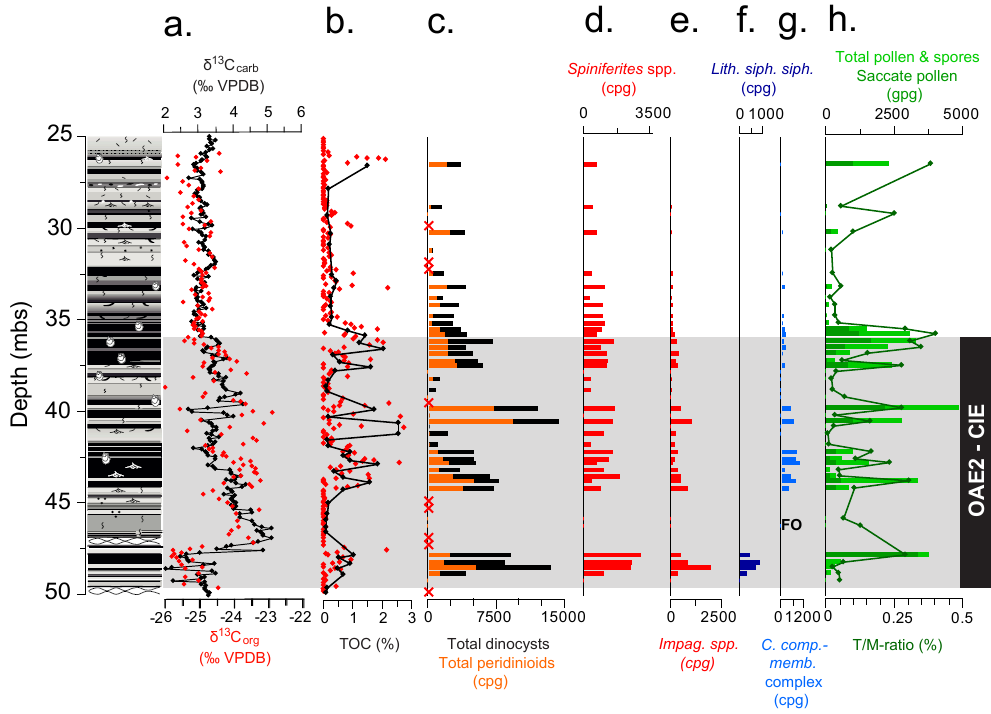
Figure 3. Geochemical and palynological results for the Cenomanian–Turonian transition of the Wunstorf core. Stratigraphy from Voigt et al. (2008). (a) δ 13 C carb (Voigt et al., 2008) and δ 13 C org (du Vivier et al., 2014; red). (b) Total organic carbon (TOC: black, this study; red, Hetzel et al., 2011). (c) Total dinocyst concentrations (black) and total peridinioid cysts (orange) per gram sediment dry weight (cpg). (d) Dinocyst species Spiniferites spp. (cpg). (e) Dinocyst species Impagidinium spp. (cpg). (f) Dinocyst species Lithosphaeridium siphoniphorum siphoniphorum (cpg). (g) Dinocyst species Cyclonephelium compactum – C. membraniphorum complex (cpg). (h) Terrestrial vs. marine palynomorphs (T / M ratio) and total pollen and spores in grains per dry gram of sediment (gpg); saccate gymnosperm pollen in dark green. The grey zone indicates the OAE2 interval after Voigt et al.